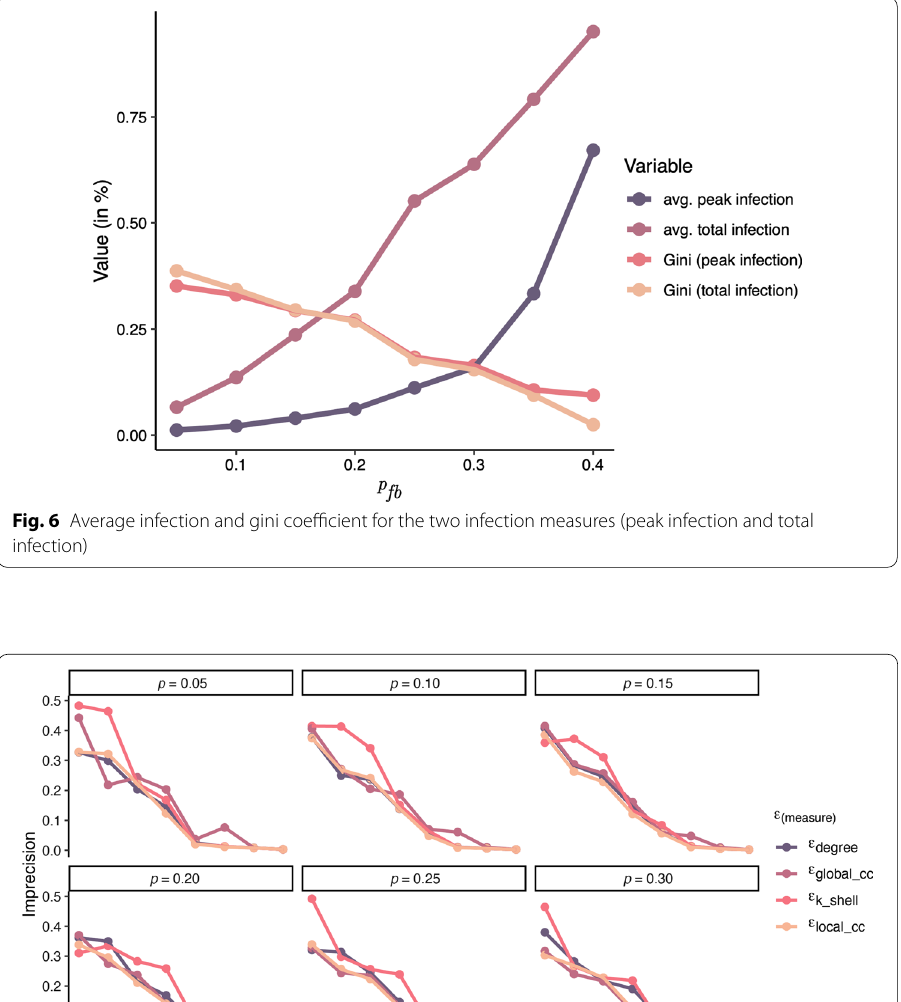
values for p fb the networks are denser and several communities merge into a giant component during network evolution as described above. In such networks, almost every node is a good spreader and all measures perform similar. Across all p values, mean imprecision values are 0.14 for degree, 0.17 for k -Shell, .15 for global _ cc and .13 for local _ cc . However, for networks created with smaller forward burning probability p fb ≤ 0.2 larger differences in the imprecision can be observed (0.26 for degree, 0.31 for k -Shell, 0.26 for global _ cc and 0.24 for local _ cc ) showing that the local and global community centrality are slightly superior to the degree and definitely to the k -shell index for identifying good spreaders in such networks. For those generated with forward probability p fb > 0.2 however, differences between the measures become